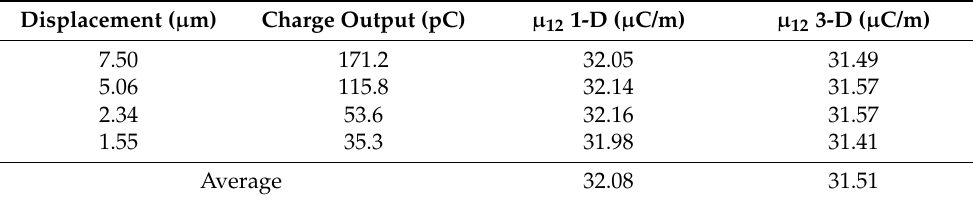
Table 2. Experimental results of the flexoelectric charge output for various input